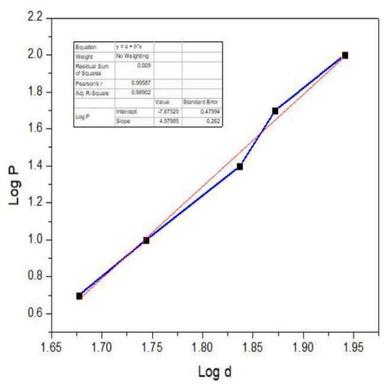
The least square fit - log P vs log d.